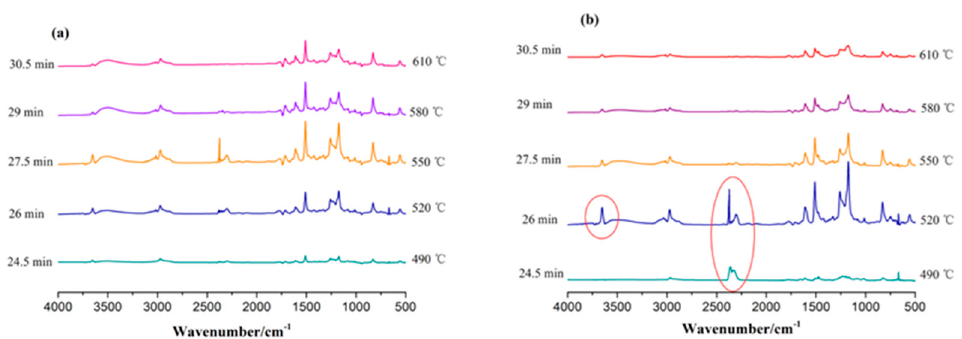
Figure 9. TG-IR spectra of pure PC ( a ) and PC / HSPCTP3 ( b ) at di ff erent decomposition